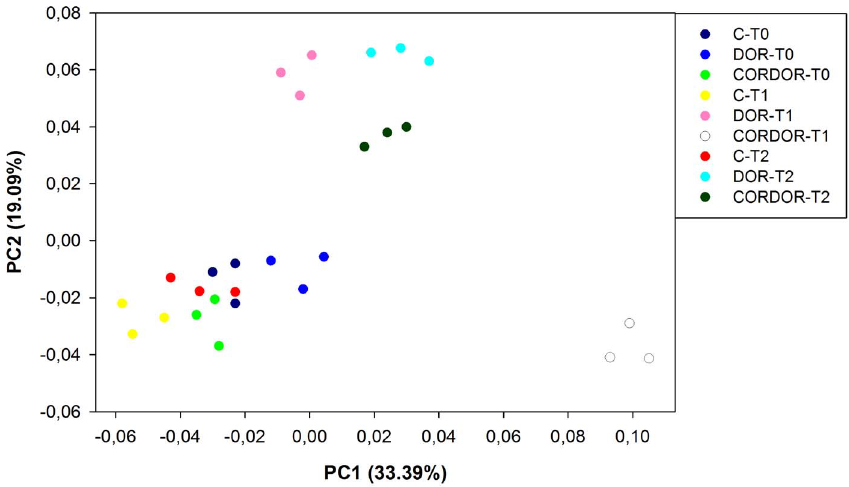
Figure 3. PCoA based on Euclidean distances of community level physiological profile (CLPP) dataset for unamended soil (C) and soil amended with untransformed DOR (DOR) or C.floccosa –transformed DOR (CORDOR) at 0 (T0), 30 (T1) and 60 (T2) days. Percent variability explained by each principal coordinate is shown in parentheses after each axis legend.